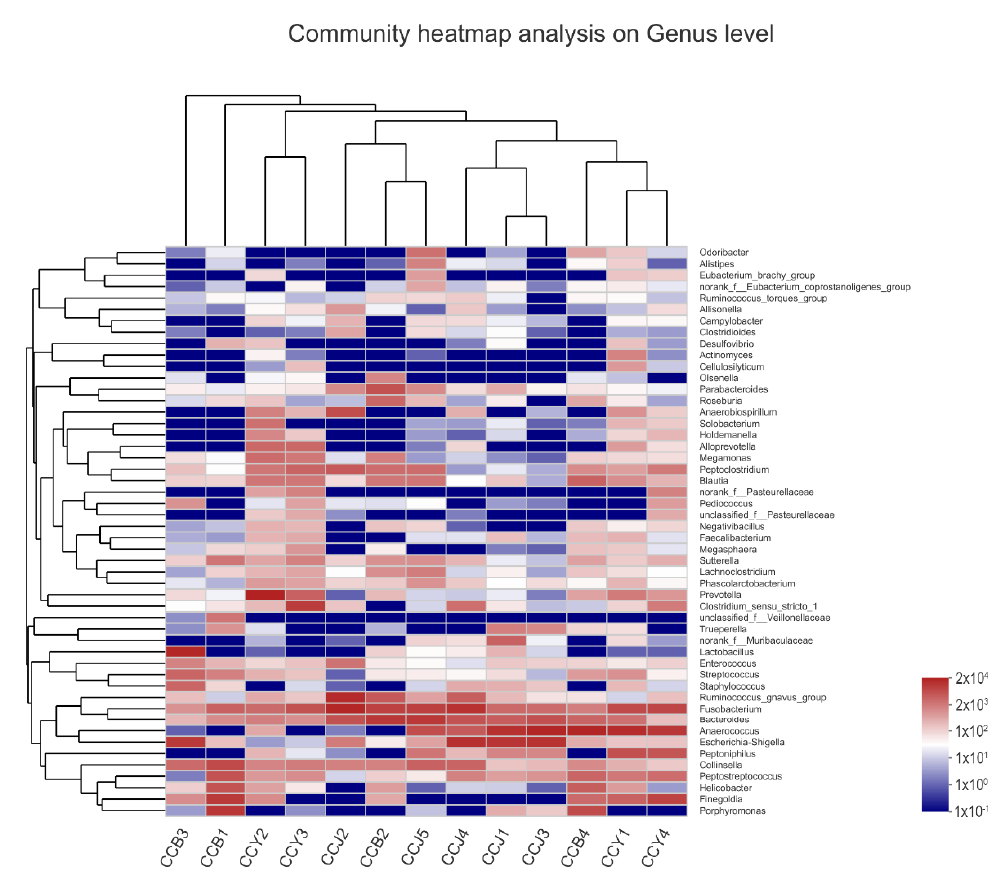
Figure 4. Heatmap of the hierarchy cluster results for the abundance of genus. The color of the spots corresponds to the normalized and log-transformed relative abundance, and the genus names are shown on the right.